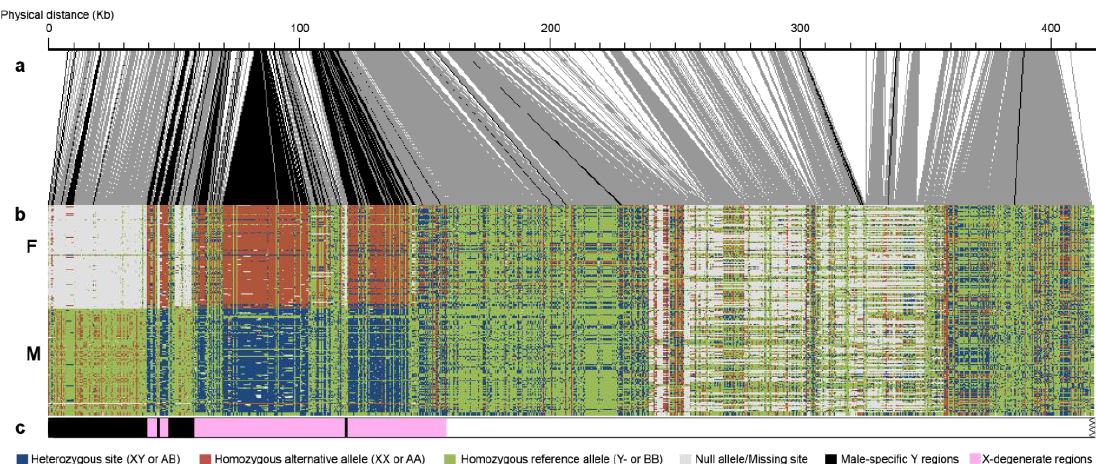
Figure 3. Genotype configurations of 200 individuals in the identified sex-linked region. ( a ) Schematic of the physical positions of SNPs. Black lines connecting to panel b indicate significant associations with sex. ( b ) The genotype configuration of the SDR and the adjacent pseuodoautosomal region. ( c ) Schematic interpretation of the genotype configurations in panel b.